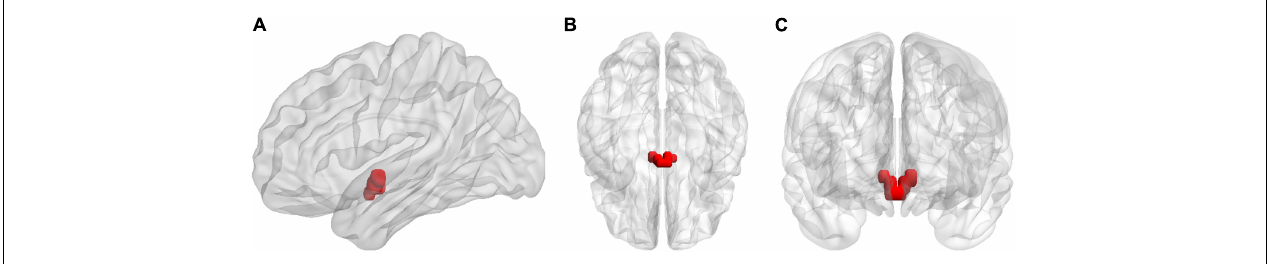
FIGURE 1 | Seed regions for the hypothalamus in (A) sagittal, (B) axial, and (C) coronal views.